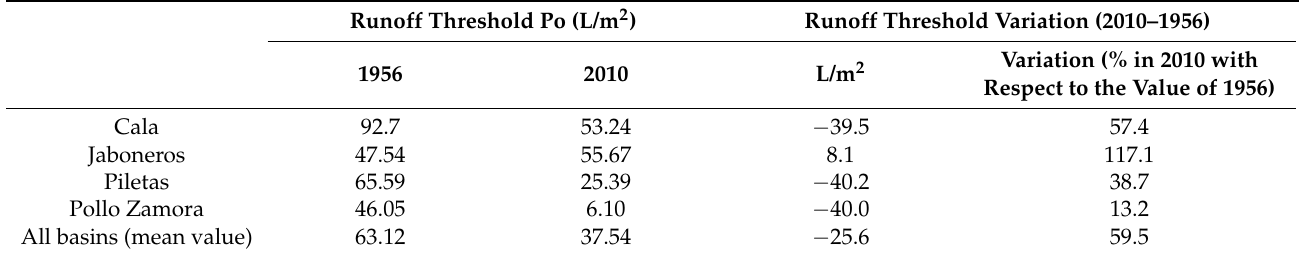
Table 5. Infiltration capacity or runoff threshold (L/m 2 ) in 1956 and comparative with respect to 2010 values.